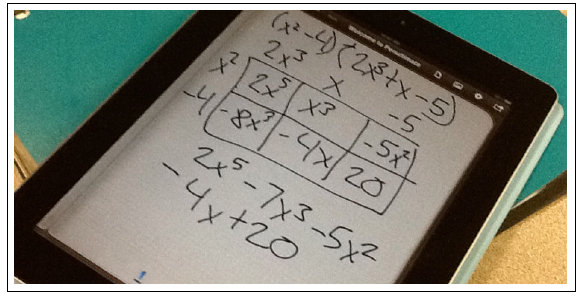
Figure 3. Students used the iPad to work on exercises involving product of polynomials.